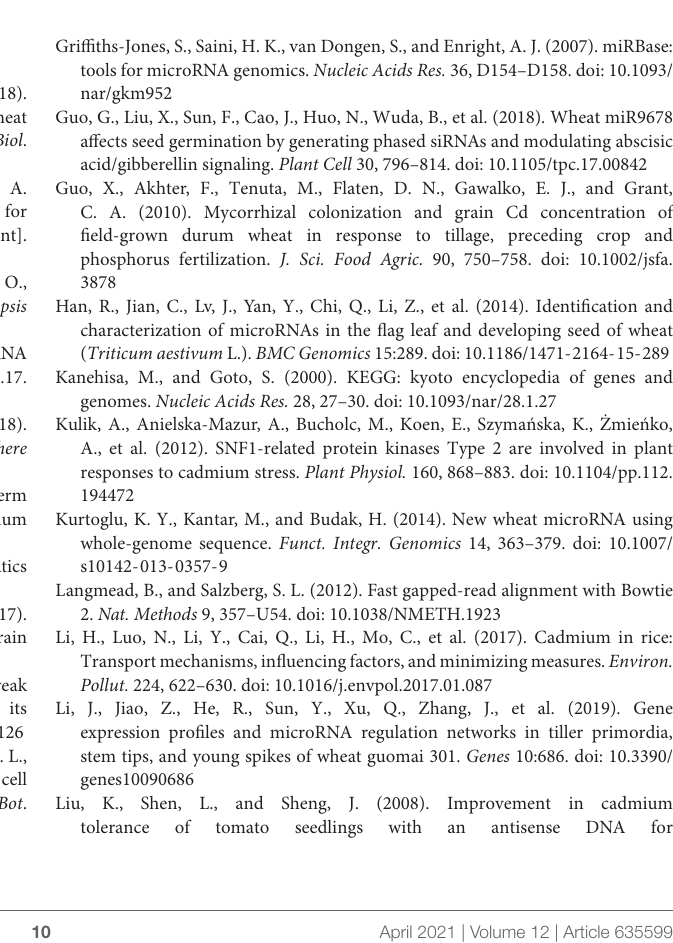
Supplementary Table 5 | Novel miRNA related to wheat cadmium